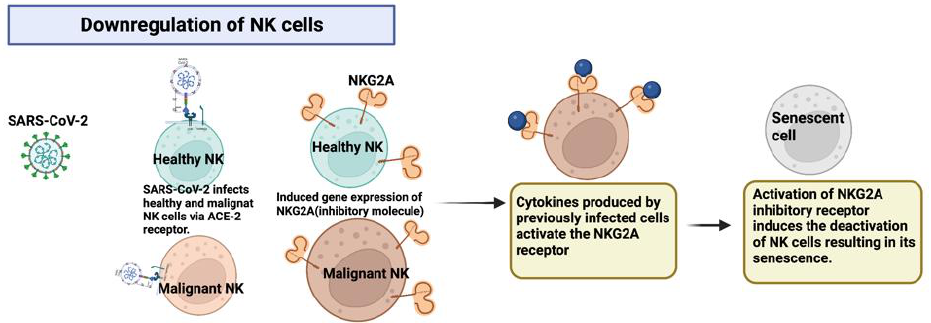
Figure 3. SARS-CoV-2 infects both healthy and malignant NK cells and promotes the expression of the inhibitory molecule NKG2A, thus causing cell senescence. Created with BioRender.com.